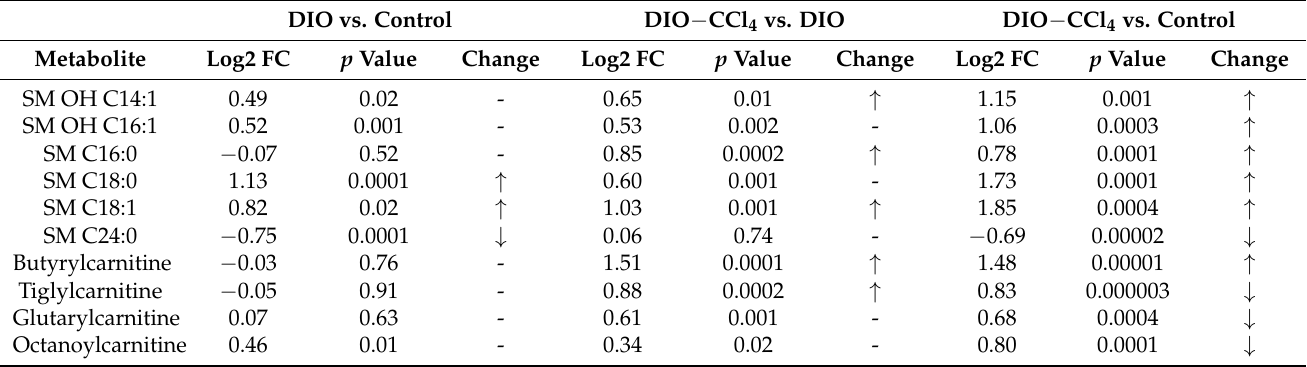
Table 3. Summary of differential metabolites in liver between different groups (SMs and acylcarnitines). DIO vs. Control DIO − CCl 4 vs. DIO DIO − CCl 4 vs. Control Metabolite